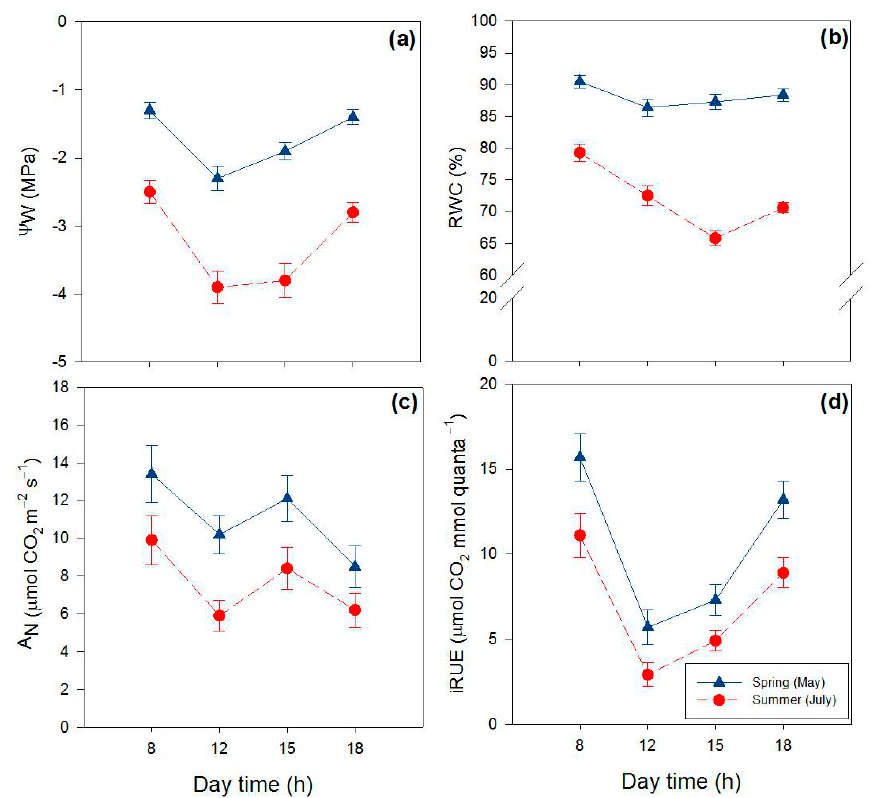
Figure 1. Seasonal and daily variations in leaf water potential ( ψ W , a ), relative water content (RWC, b ), net CO 2 assimilation rate (A N , c ) and instantaneous radiation use efficiency (iRUE, d ) in P. latifolia leaves. Measurements were conducted at 08:00–09:00 (8 h in the graphs), 12:00–13:00 (12 h), 14:30–15:30 (15 h) and 17:30–18:30 (18 h) hours at two dates in spring (11–12 and 25–26 May, blue lines) and summer (4–5 and 22–23 July, red dashed lines) on clear days. Data are reported as means ± SD ( n = 8).